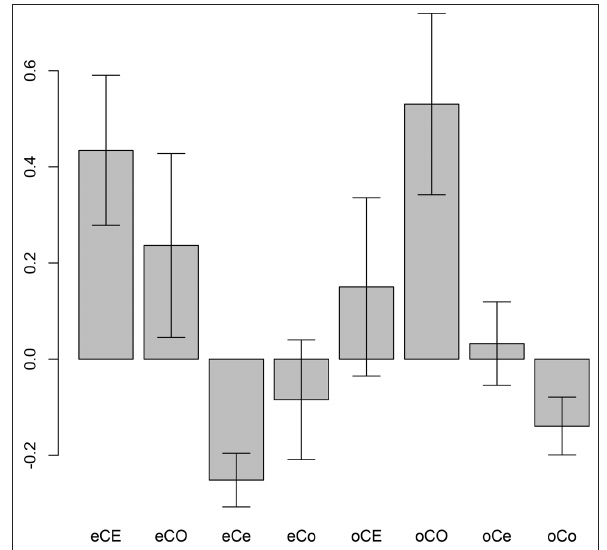
Figure 6: Normalized F1 of pretonic mid vowels as function of the F1 of the tonic vowel (E = [ ɛ́ ] and O = [ ɔ́ ]). Error bars are 95% confidence